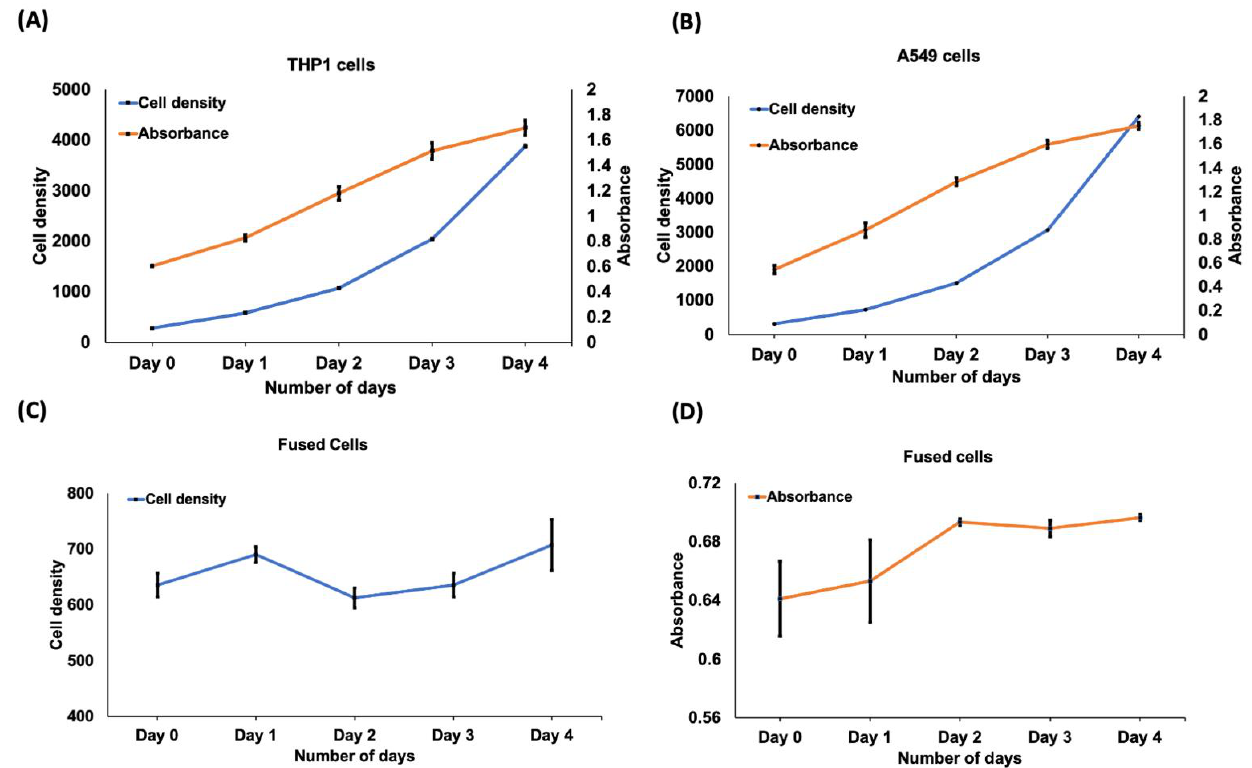
Figure 8. Cell viability using PrestoBlue ® reagent ( A ) The graph showing cell density and absorbance was plotted for THP-1 ( B ) The graph showing cell density and absorbance was plotted for A549 from day 0 to day 4. ( C , D ) The graph showing cell density and absorbance was plotted for fused cells from day 0 to day 4. The absorbance values indicate that the cells are viable. Error bars, mean ± s.d., ( n = 2) ( p < 0.05). This study was performed using non-fluorescence labelled cells.